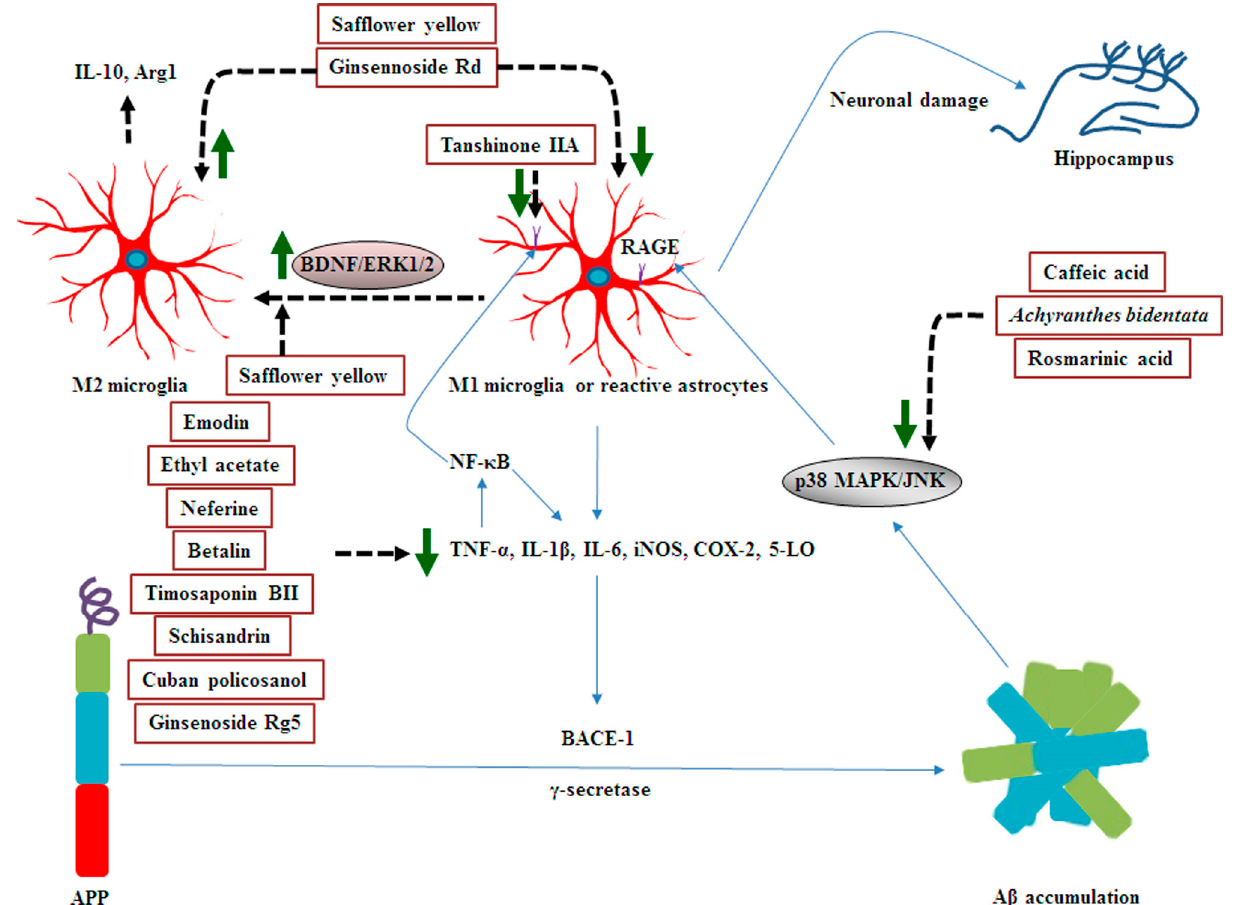
Figure 4. Schematic representation of the effects of MHDIs on A β -induced inflammation in the cortex and hippocampus in the early and late phases of AD in in vivo models.